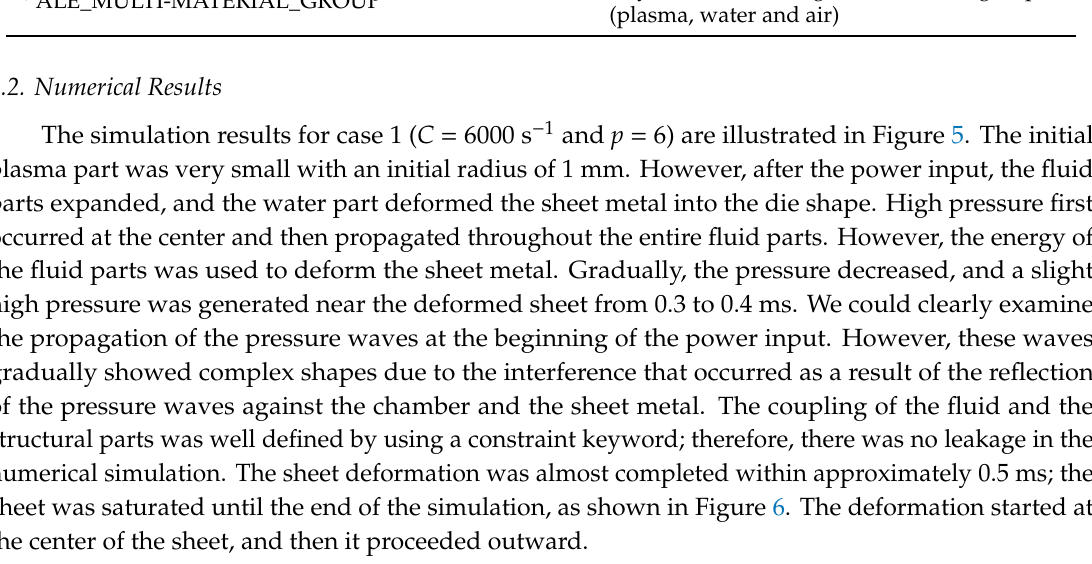
Figure 6. Bulge height of the deformed sheet metal. Figures 7 and 8 show the forming velocity and strain rate for the sheet at three points. As described in the introduction, the sheet metal was deformed with very high velocity above 100 m/s